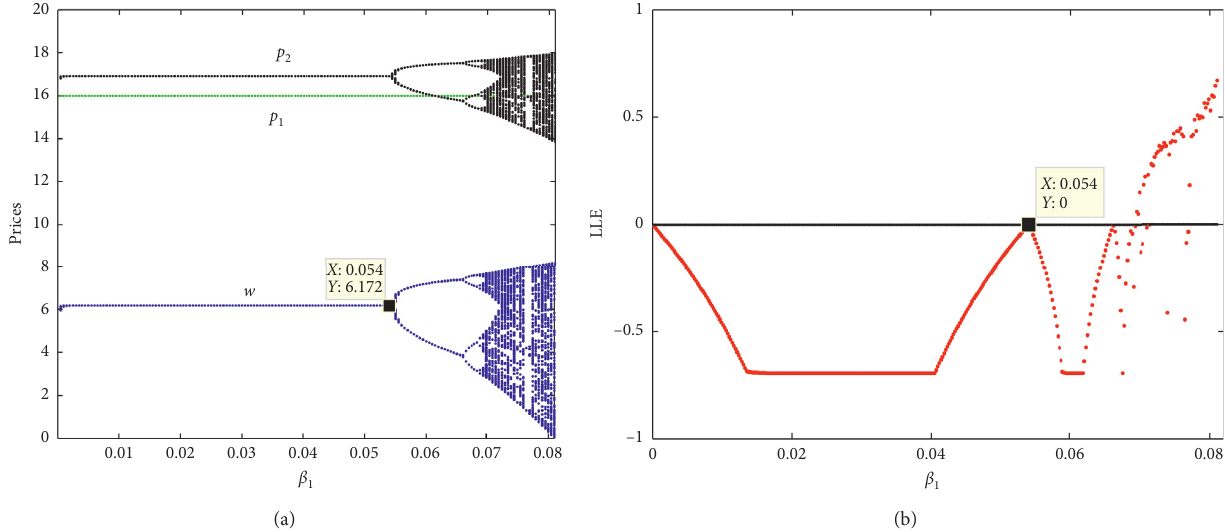
Figure 22: The behavior of dynamic system (25) with respect to β